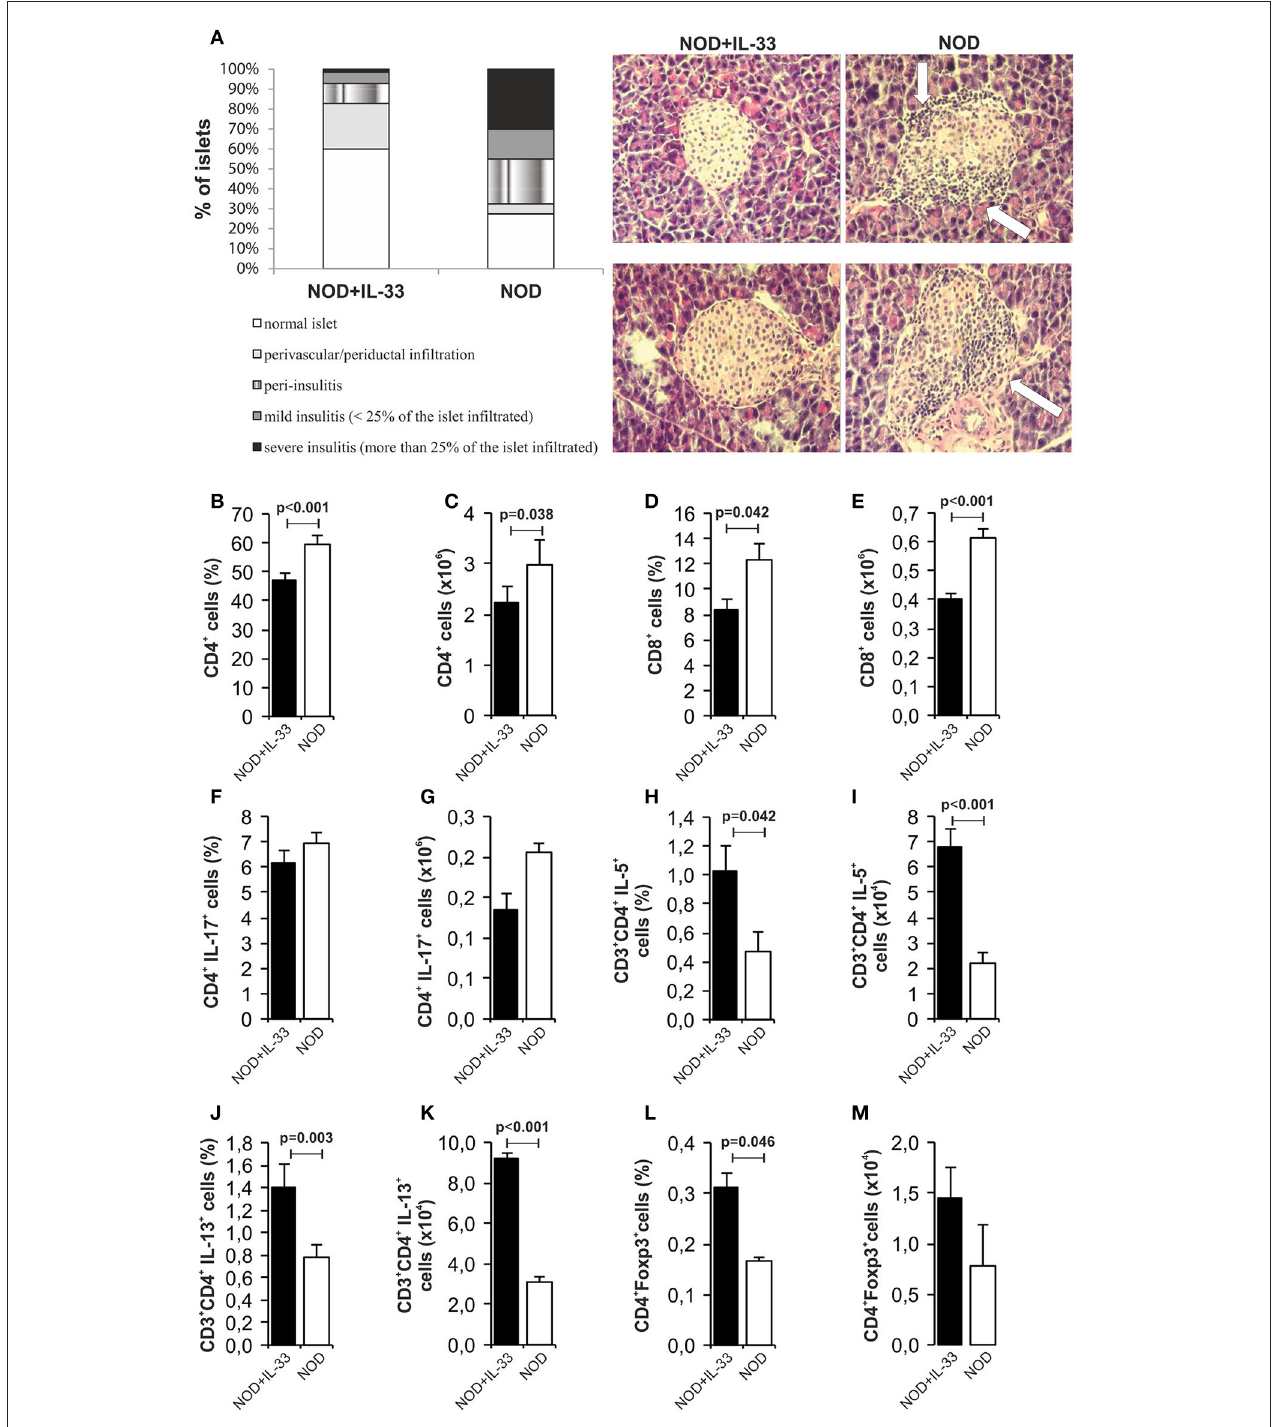
FIGURE 7 | IL-33 decrease insulitis and change composition of mononuclear islet infiltration in prediabetic NOD mice. 16 weeks old animals that were all normoglycemic, free of glycosuria and with normal GTT test were treated with 6 injections of 0,4 µ g/mouse IL-33 (every second day) and sacrificed for histological analysis at 18th week of age (A) . The percentage and number of CD4 + (B,C) , CD8 + (D,E) , CD4 + IL-17 + (F,G) , CD3 + CD4 + IL-5 + (H,I) , CD3 + CD4 + IL-13 + (J,K) , CD4 + Foxp3 + (L,M) was examined by flow cytometric analysis. IL-33 treatment significant increase percentage of CD3 + CD4 + IL-5 + (H,I) , CD3 + CD4 + IL-13 + (J,K) and regulatory CD4 + Foxp3 + (L,M) cells. Data from one experiment with 10 mice per group are shown as mean ± SEM; by paired t -test when compared with values obtained with phosphate-buffered saline.